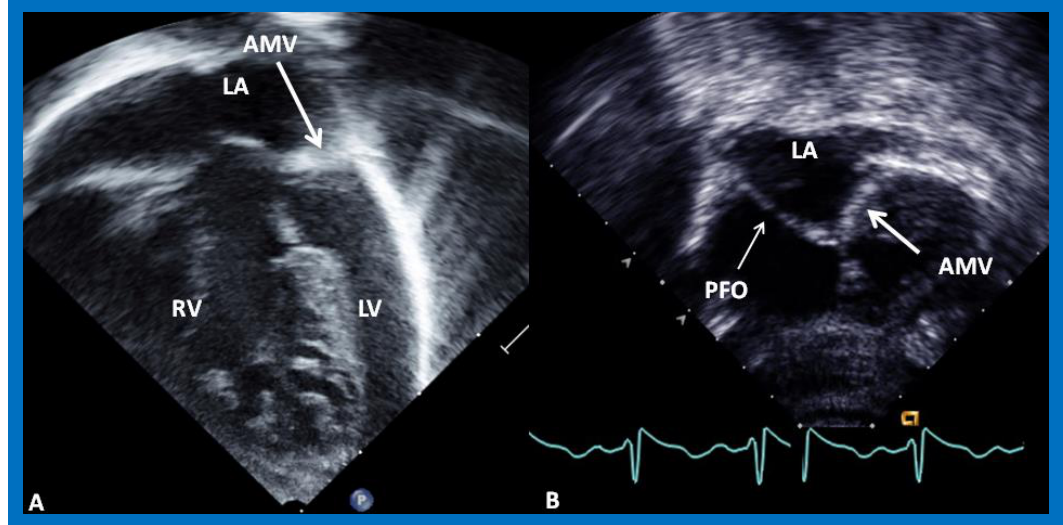
Figure 1. Selected video images from modified apical four-chamber views of two babies with mitral atresia illustrating atretic mitral valves (AMV), shown by thick arrows. The left atrium (LA) and left ventricle (LV) are small while and the right ventricle (RV) is large ( A ). A restrictive patent foramen ovale (PFO) is shown by a thin arrow in ( B ). Reproduced from [7].